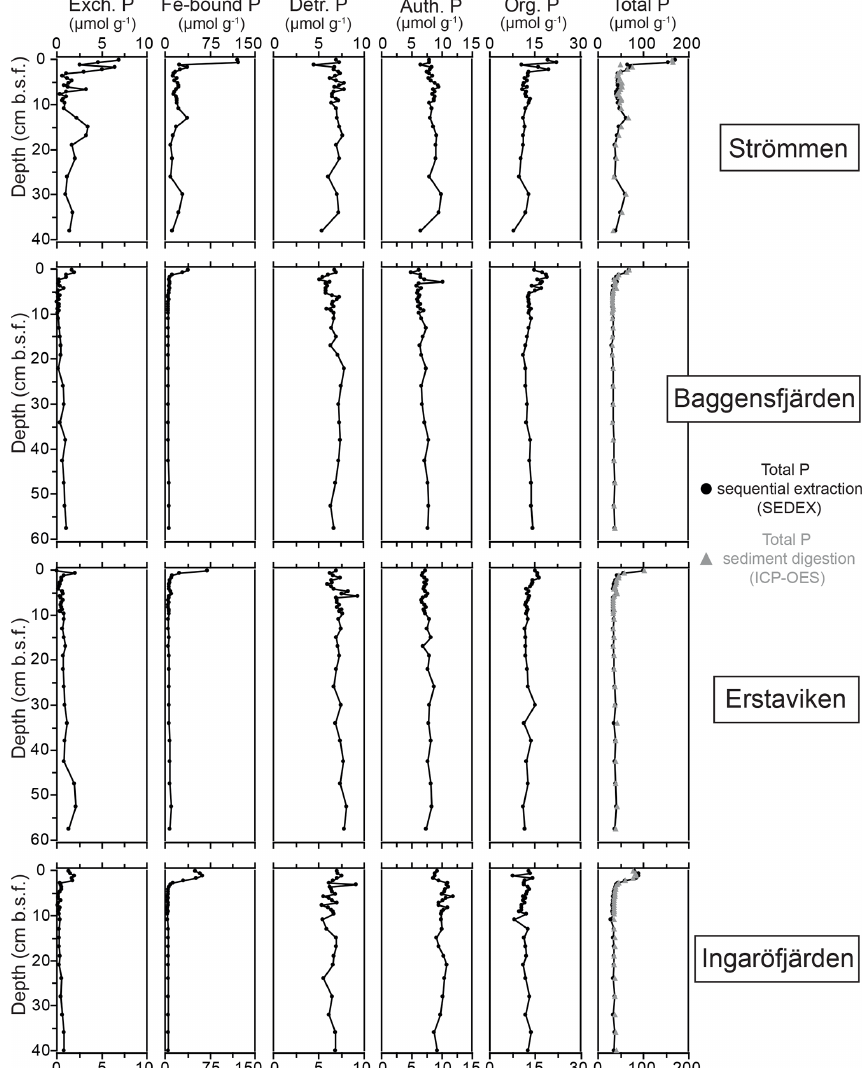
Figure 6. Depth profiles of the different fractions of solid-phase P for the study sites in the Stockholm archipelago: Strömmen, Baggens- fjärden, Erstaviken and Ingaröfjärden. Total P is the sum of the different sequentially extracted P phases (SEDEX; black dots) and the P content derived from acid-digested sediment aliquots and subsequent ICP-OES analysis for the sediment samples taken in March 2017 (grey